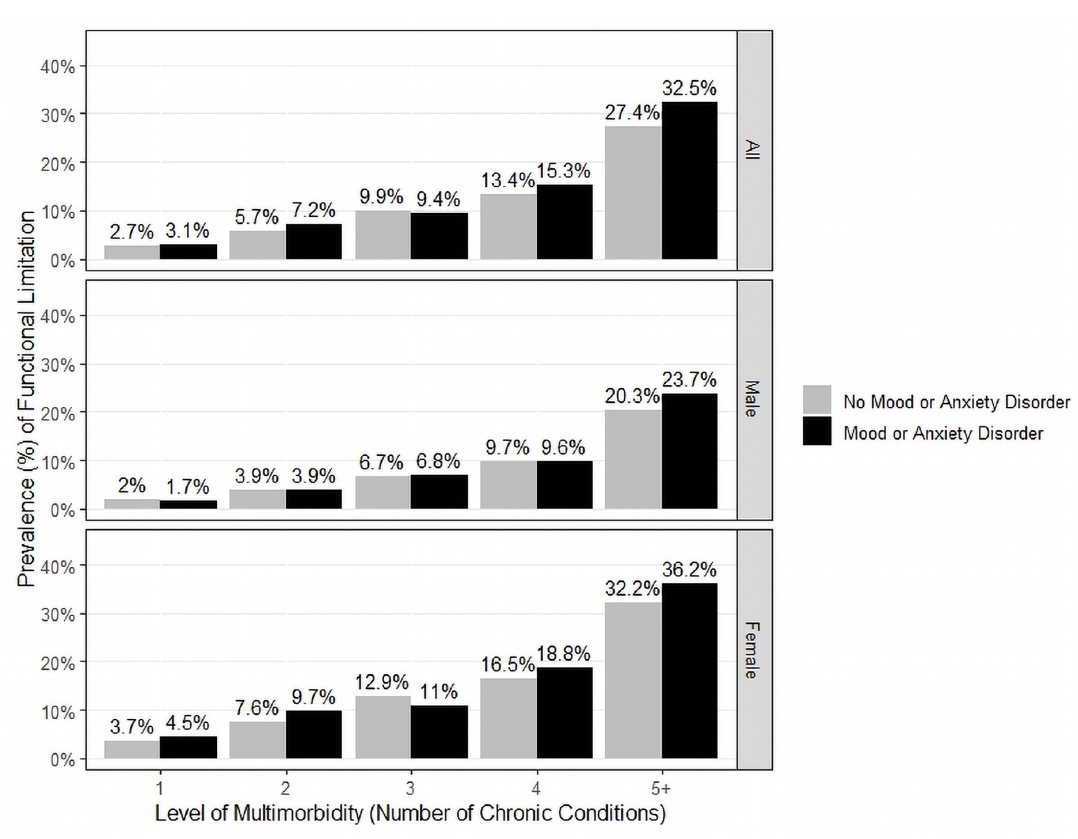
Fig 1. Prevalence of functional limitation by multimorbidity and presence of mood/anxiety disorders (all participants). (A) Prevalence of functional limitation by multimorbidity and presence of mood/anxiety disorders (women). (B) Prevalence of functional limitation by multimorbidity and presence of mood/anxiety disorders